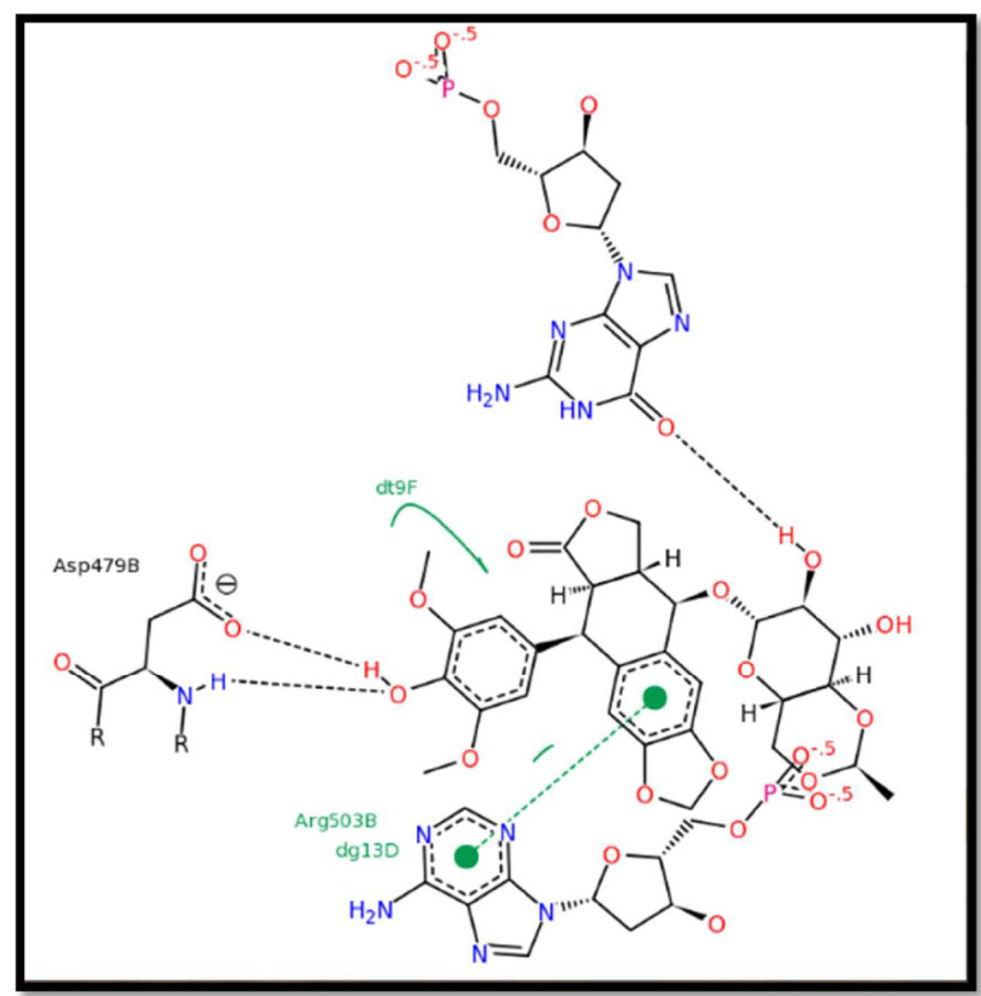
Figure 4. Reported etoposide-binding mode in the active site of the TOP II β enzyme.